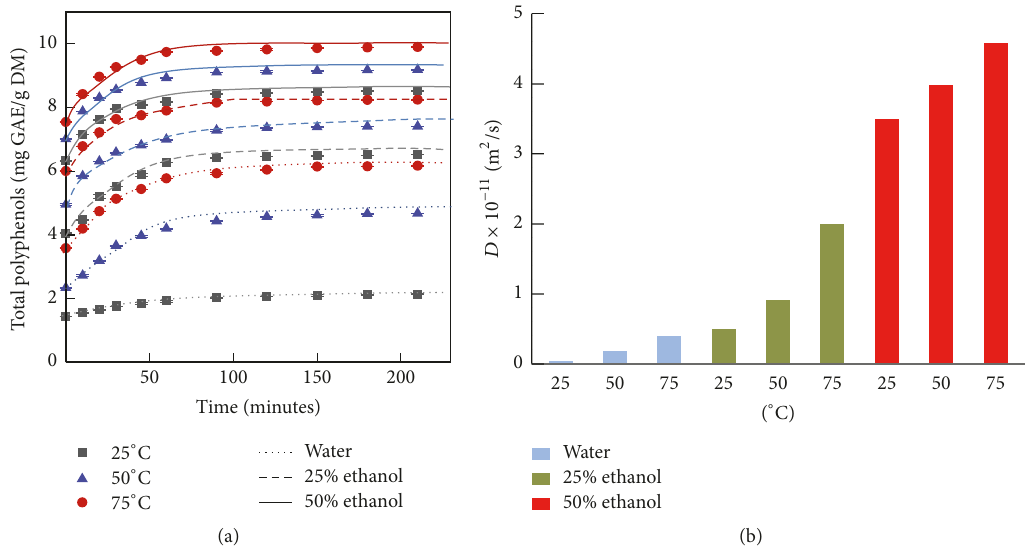
Figure 1: (a) Kinetics of the solid-liquid extraction of polyphenols from apricot pomace with different temperatures (25 ∘ C, 50 ∘ C, and 75 ∘ C) and ethanol concentrations (water, 25% and 50% ethanol) for 210 minutes. (b) Polyphenol diffusion coefficients of apricot pomace during the kinetics with different temperatures (25 ∘ C, 50 ∘ C, and 75 ∘ C) and solvent ratios (water, 25% and 50%